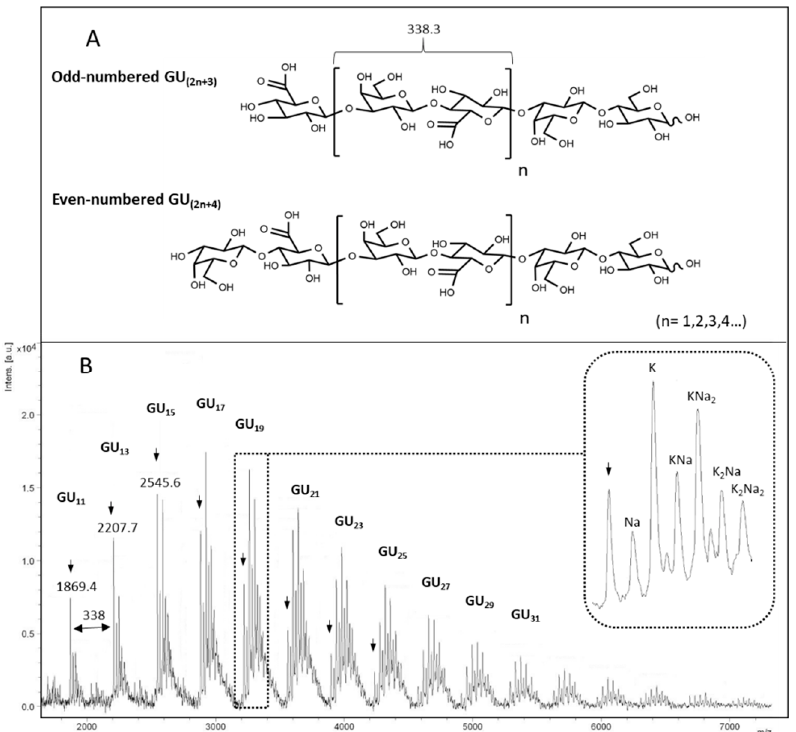
Figure 5. Possible structures of chondbiuronan depending on reducing termini ( A ) and negative-ion linear MALDI mass spectrum of compound 1 ( B ). Acidic [M-H] - peaks are denoted by arrows. Na/H and K/H exchanges are observed increasingly with molecular weight (enlarged peaks).